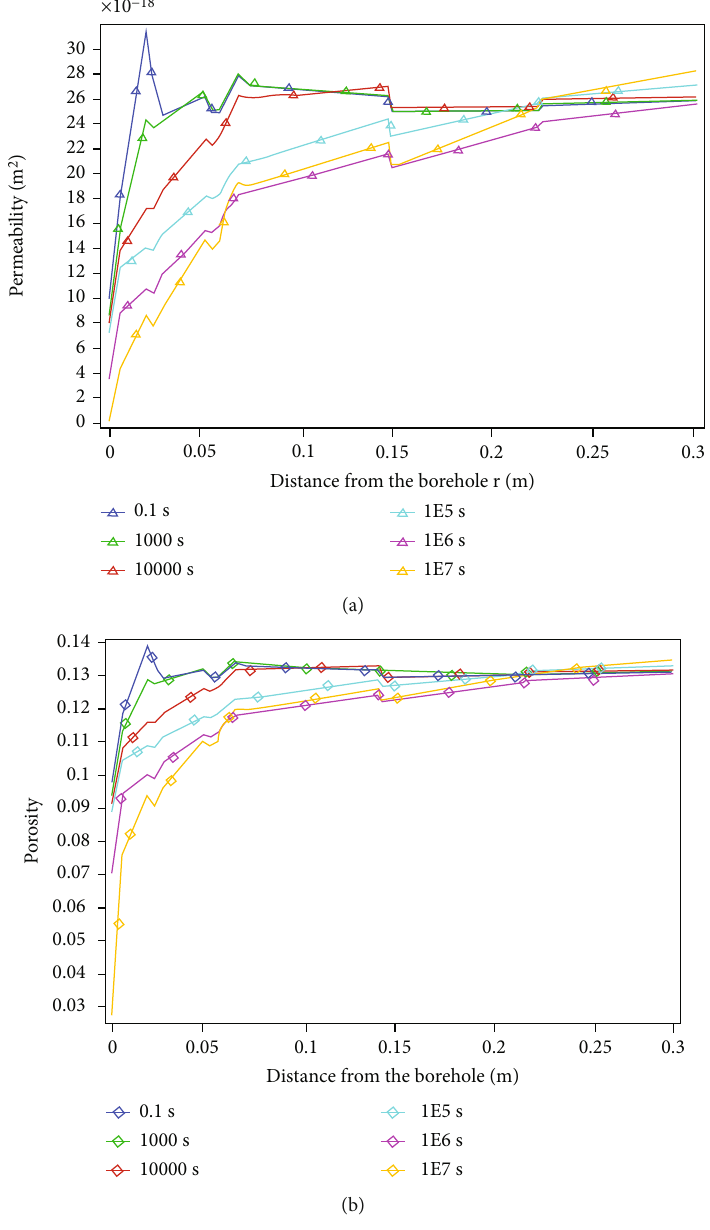
Figure 23: (a) Gas permeability and (b) porosity in the m = 3 coal rock during CBM